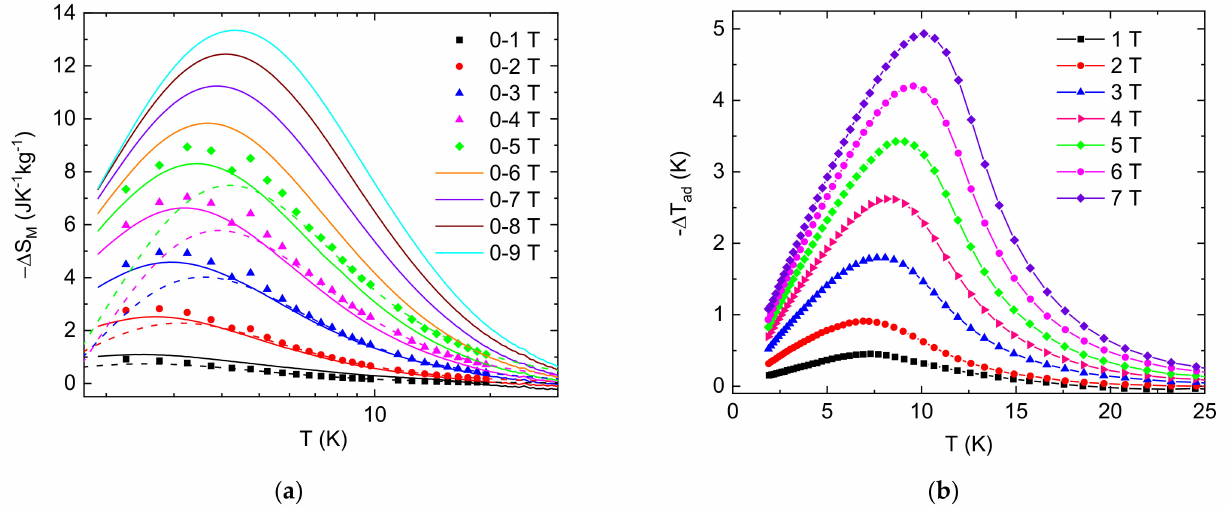
Figure 6. ( a ) Temperature dependence of the isothermal entropy change of NiHmal in different magnetic fields. − ∆ S M were obtained from the magnetization curves (symbols); solid lines represent values of − ∆ S M calculated from specific heat data. Dashed lines represent values of − ∆ S M calculated for S = 1 paramagnet with D / k B = − 7.82 K, E / k B = − 2.15 K, and g = 2.29; ( b ) Adiabatic temperature change as a function of initial temperature for the NiHmal system realized under conditions of adiabatic demagnetization to zero magnetic